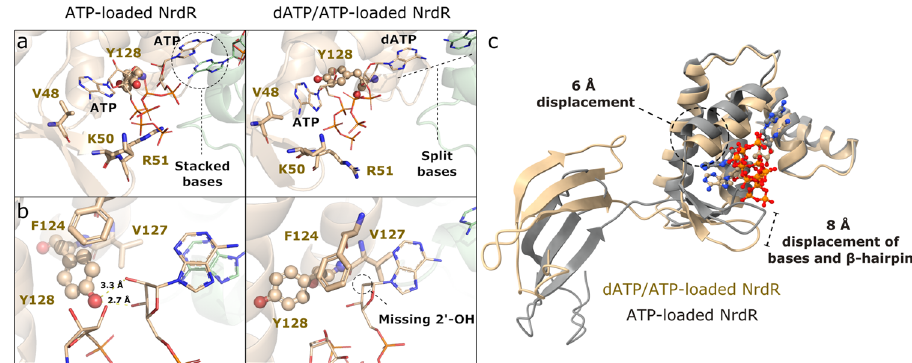
Fig. 5 Nucleotide binding to NrdR. a Nucleotide-binding site of the ATP-loaded NrdR dodecamer (left) and dATP/ATP-loaded NrdR tetramer (right). Chain A is colored in beige and chain B is colored in green. b Close-up illustration of the displacement of Y128 (highlighted in ball-and-stick view) between ATP-loaded NrdR (left) and dATP/ATP-loaded NrdR (right). c ATP-loaded NrdR chain A (gray) aligned with dATP/ATP-loaded NrdR chain A (beige), highlighting the most prominent displacements between them. The alignment was made with the ATP-cone